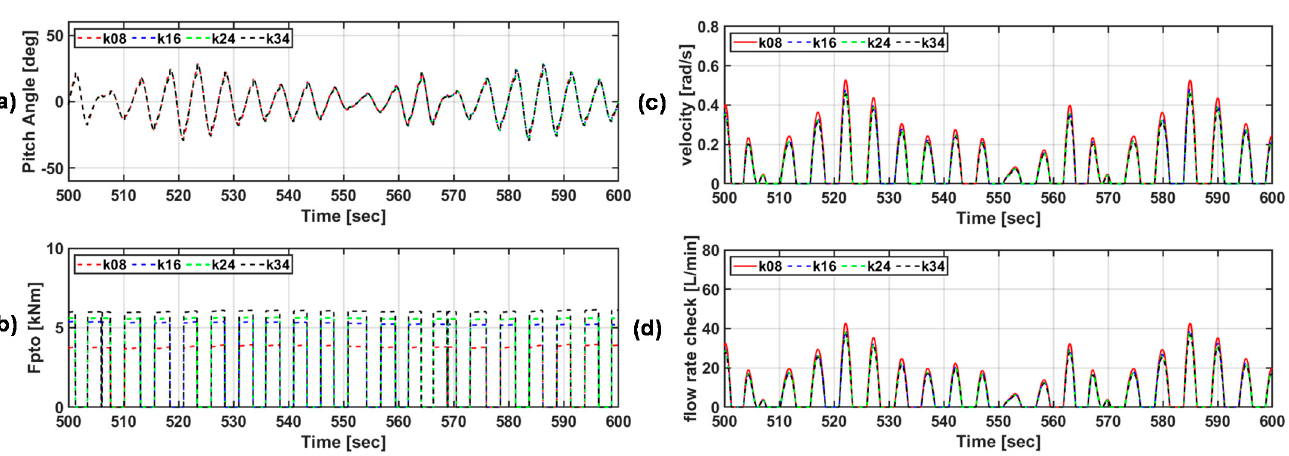
Figure 20. ( a ) Floating body pitch angle, ( b ) PTO force, ( c ) floating body velocity, and ( d ) occurrence flow rate according to torque coefficient of optimal torque control algorithm flux under irregular wave conditions ( H s = 0.75 m, T p = 4.75 s) (legends indicate torque coefficients).